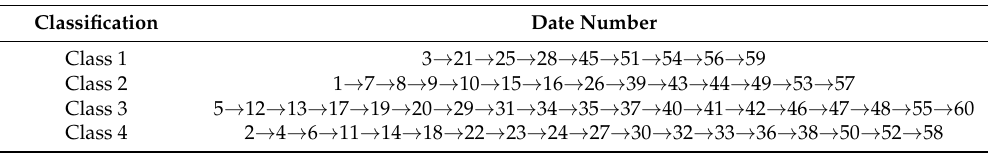
Table 4. Results of ant colony clustering algorithm.